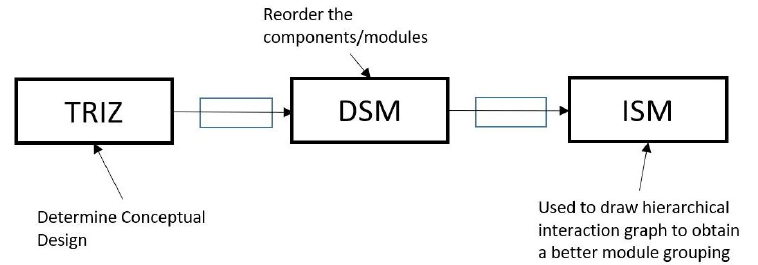
Figure 7. TRIZ, DSM, and ISM Tool Integration